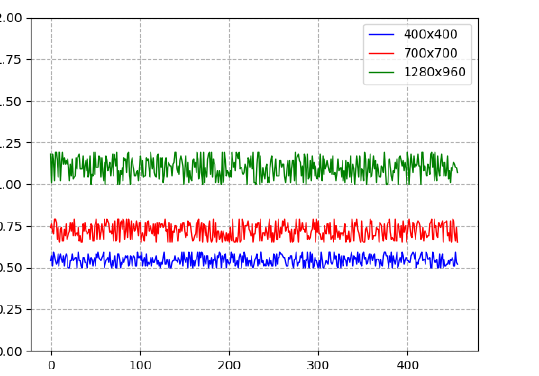
Figure 21. Keypoint recognition performance: frame processing time (s) vs. frame number in video sequence.